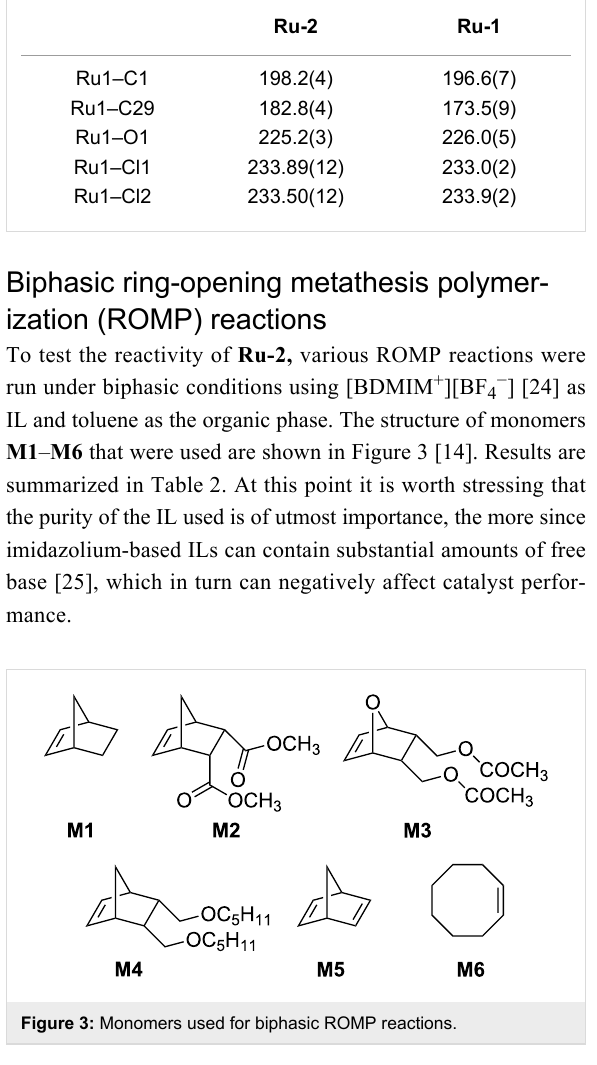
Figure 3: Monomers used for biphasic ROMP